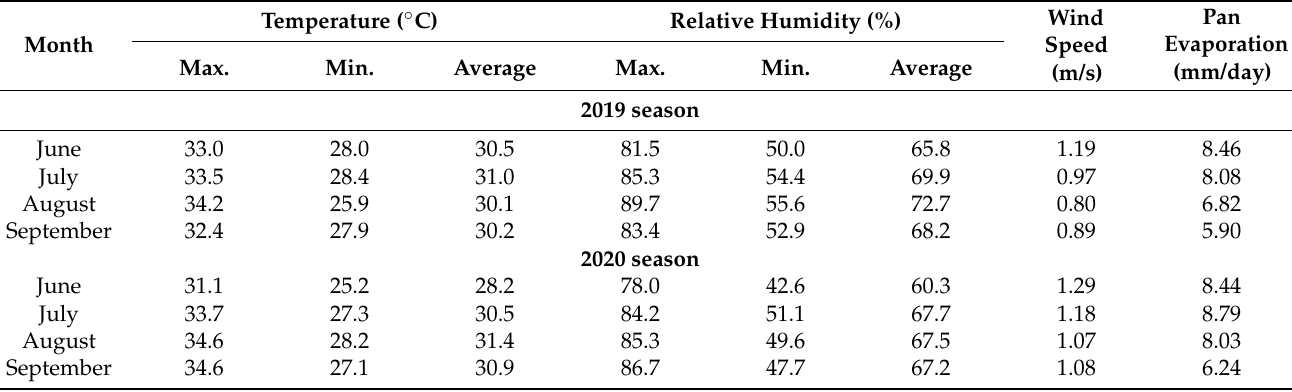
Table 3. Meteorological data for Kafr El-Sheikh during 2019 and 2020 summer